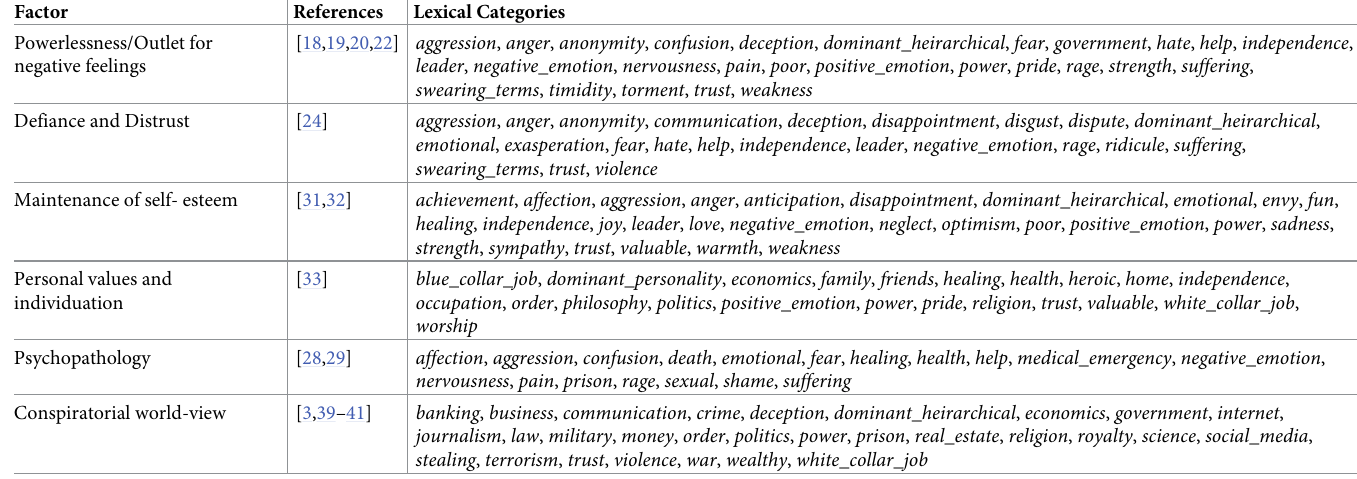
Table 1. Lexical categories used from Empath mapped to factors associated with conspiratorial belief.